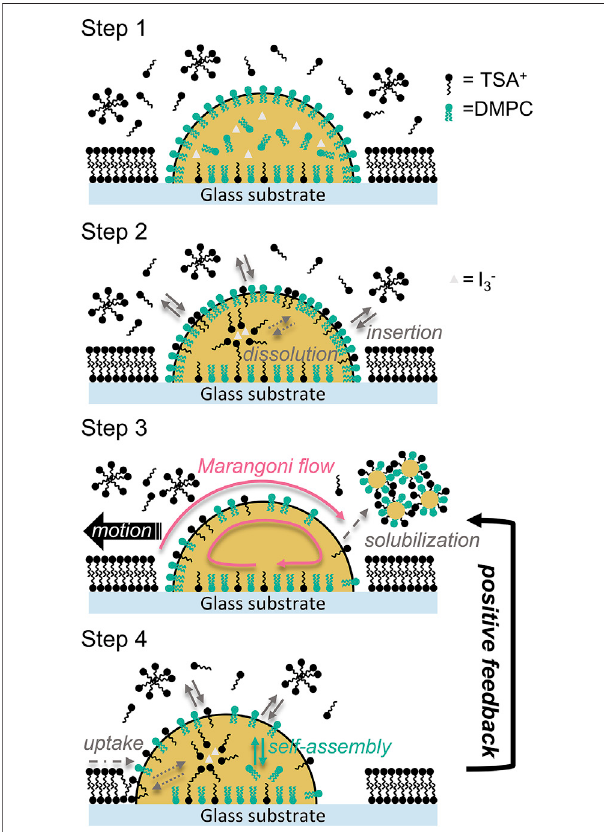
FIGURE 6 | Mechanism of the self-propelled motion of the nitrobenzene dropletobserved in thisstudy. Step 1 : Initial state oftheoil phase (the droplet) andwaterphasecontainingTSAC,correspondingtothesituationimmediately after the droplet was dispensed. Step 2 : Insertion of TSAC into the DMPC membrane layer and dissolution of TSAC in the oil phase assisted by I 3 − . Step 3 : Symmetry breaking of the interfacial tension at the oil – water interface owing to the solubilization by the formation and ejection of DMPC/ TSA + /nitrobenzene aggregates, and then the self-propelled motion. Step 4 : Recovery of the droplet condition owing to following processes: the uptake of TSA + from the front of the droplet and from the solution (reinsertion), and the self-assembly of DMPC at the interface.